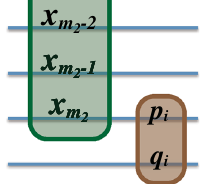
FIG. 3. In the discussion of situation (ii) (see the text), we consider the braiding between a deconfined particle X 1 region) with a condensed null particle n ð m 2 Þ